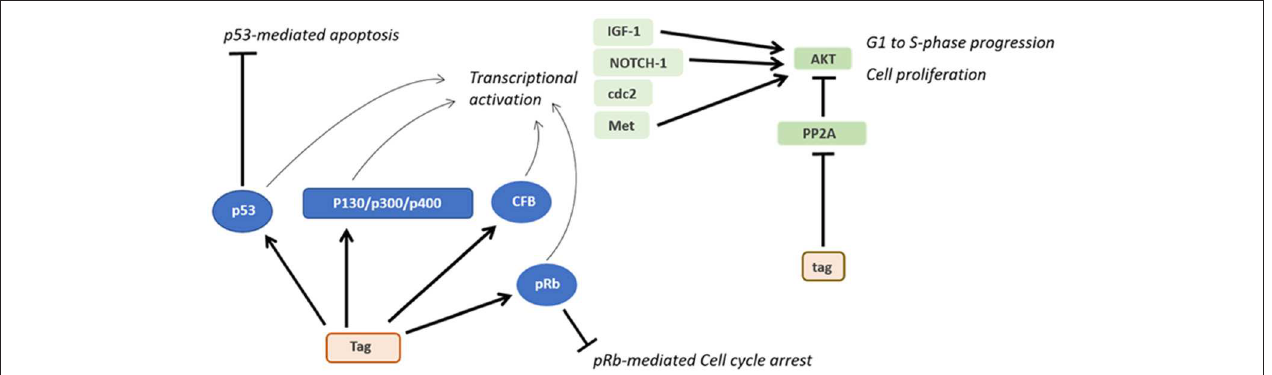
FIGURE 3 | Oncogenic activities of Tag and tag. During SV40 infection, Tag inhibits both the pRB and p53 tumor suppressor pathways. The main downstream effects of these interactions are the blocking of p53-mediated apoptosis and pRb-mediated cell cycle arrest. Furthermore, the interaction between Tag and pRB, p53 and other factors transactivates genes such as IGF-1 and Met, thereby triggering the transition from the G1 to the S-phase and the proliferation of SV40-infected cells. By inhibiting PP2A, tag activates pathways facilitating cell proliferation and